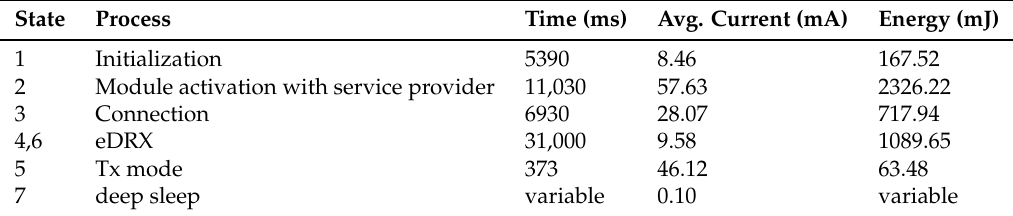
Table 6. Current composition split into different states of operation for